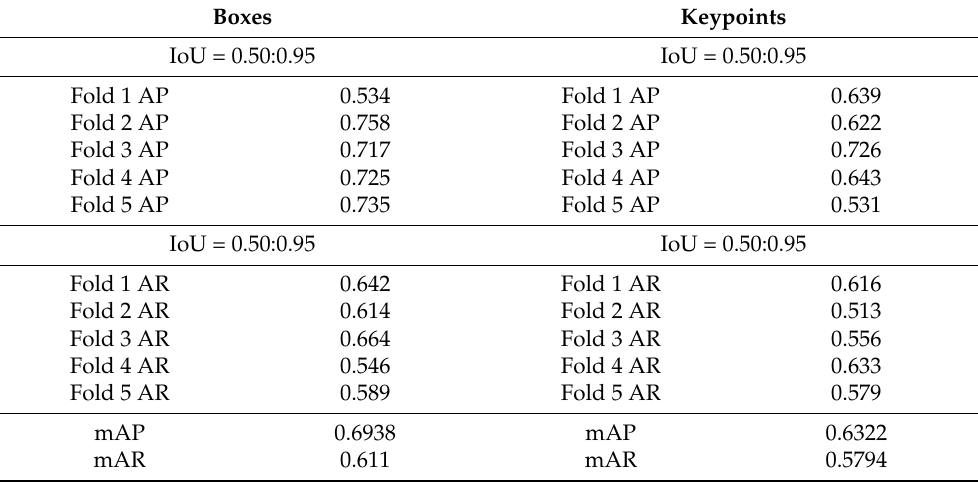
Table 1. Evaluation of the training